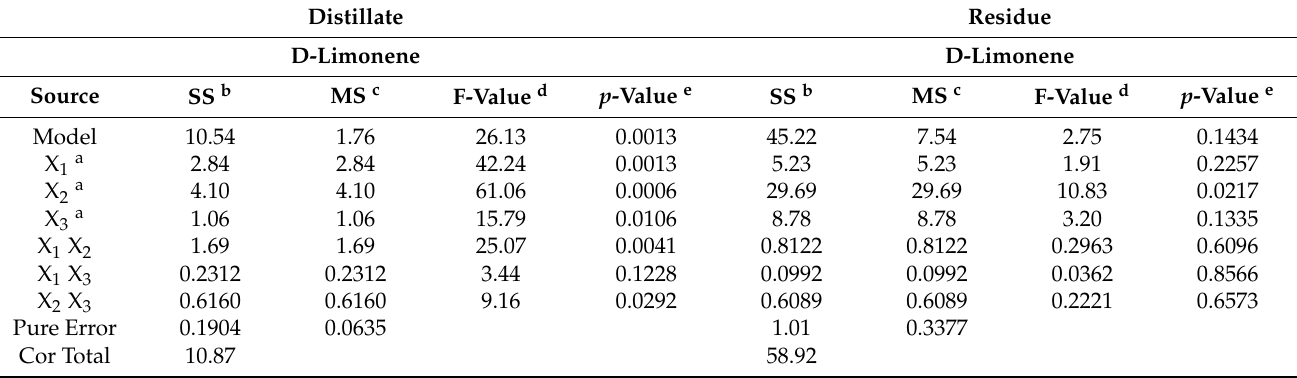
Table 7. ANOVA results for the experimental design of fractional